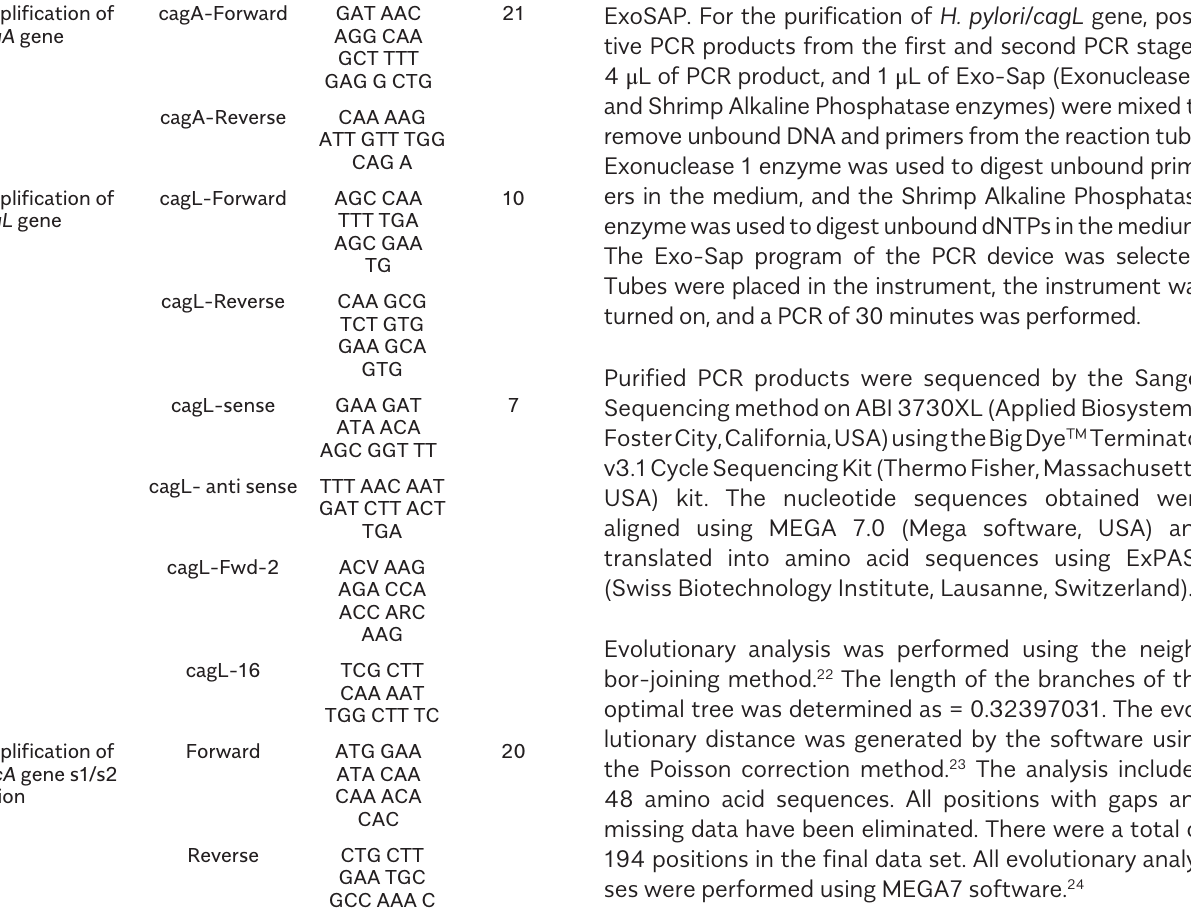
Table 1. All Primer Sets Used in the PCR Analyses